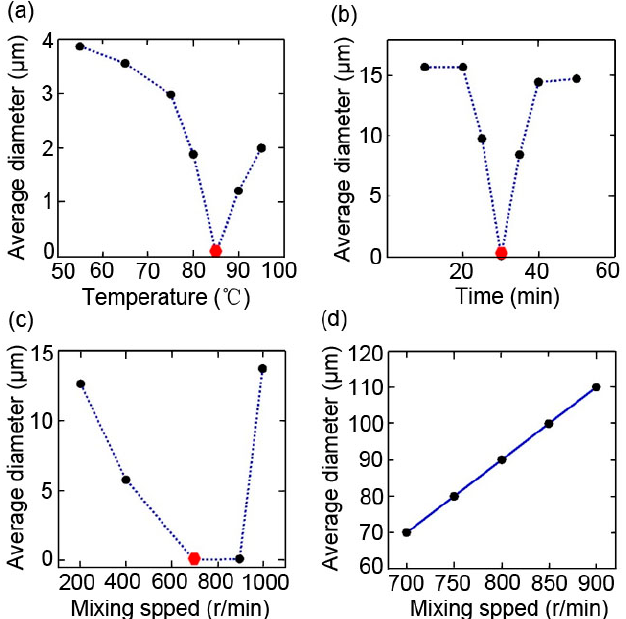
Figure 3. The average diameter of nano-SiO 2 · 0.5H 2 O particles with the di ff erent ( a ) temperature, ( b ) time, ( c , d ) mixing speed with other reagents held at the standard conditions. The red hexagon indicated the average diameter of nanoparticles synthesized at the standard conditions. The average diameter at this point is 70 nm.